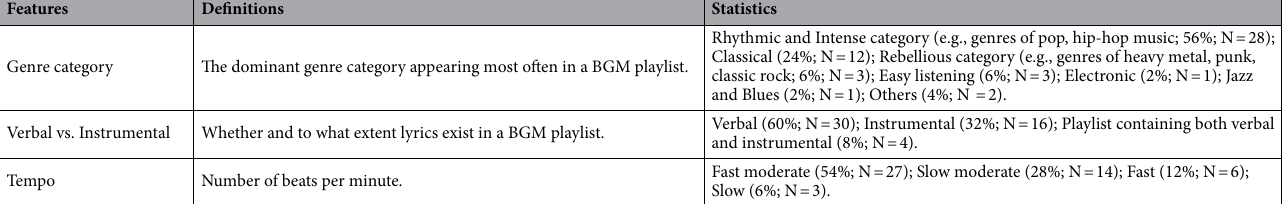
Table 3. Music features on the tracks students